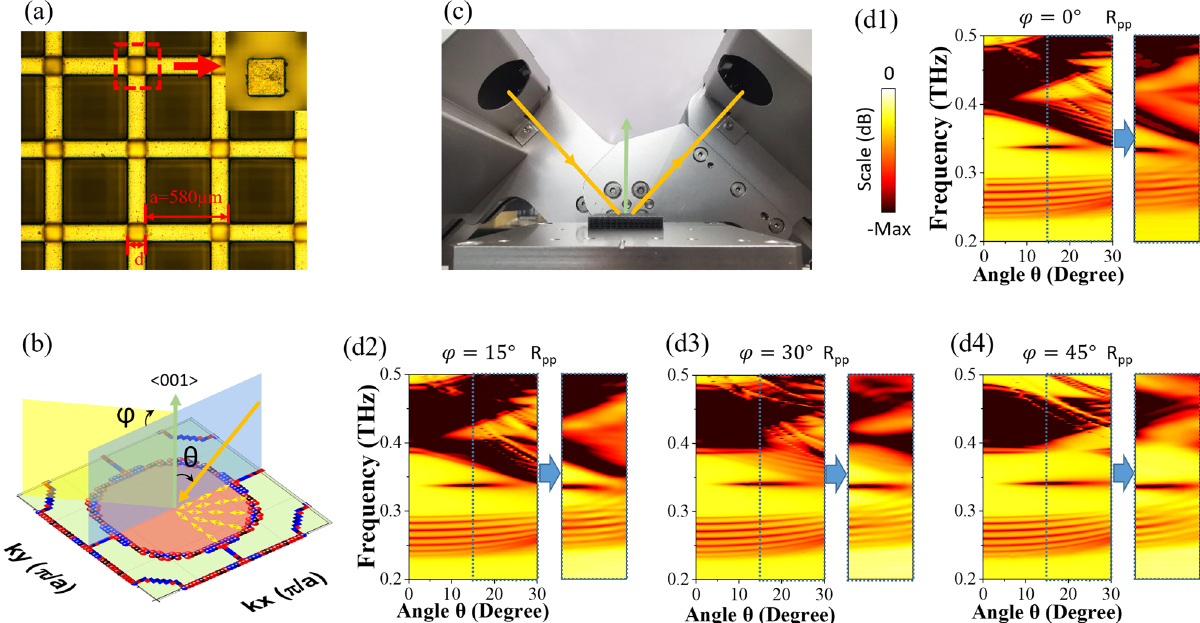
Figure 2. ( a ) Photo of the photonic crystal (after metallization) which is taken along 〈 001 〉 crystal direction. The inset shows the zoomed cross-section of the square rod on [001] surface. ( b ) Schematic picture of the 〈 001 〉 projection of the nodal chain (solid symbols, referring to band 3 and 4 in Fig. 1c) and the drumhead surface state (pink area) in k x -k y plane, where yellow arrows denote far-field polarization of the drumhead surface state and only one quadrant of polarization texture is illustrated due to C 4 symmetry. The incident wave vector (orange arrow) and two incident planes (blue and yellow planes) are also depicted for angle-resolved far-field reflection measurement. θ is the incident angle, and φ is the rotating angle of incident plane with respect to 〈 001 〉 direction. ( c ) Photo of the reflection measurement. ( d1 – d4 ) Measured and simulated far-field reflection, R pp , with E-field polarized in the incident plane for both incoming and outgoing waves (p-waves). In each panel, left diagrams with θ ranging from 0° to 30° are simulated results, and right ones with θ ranging from 15° to 30° are measured results. Both comparisons are labeled by dashed regions and blue arrows. For simulation to match well with measurement, the size, d, of the metallic rods has been fine-tuned being 125 μm in numerical